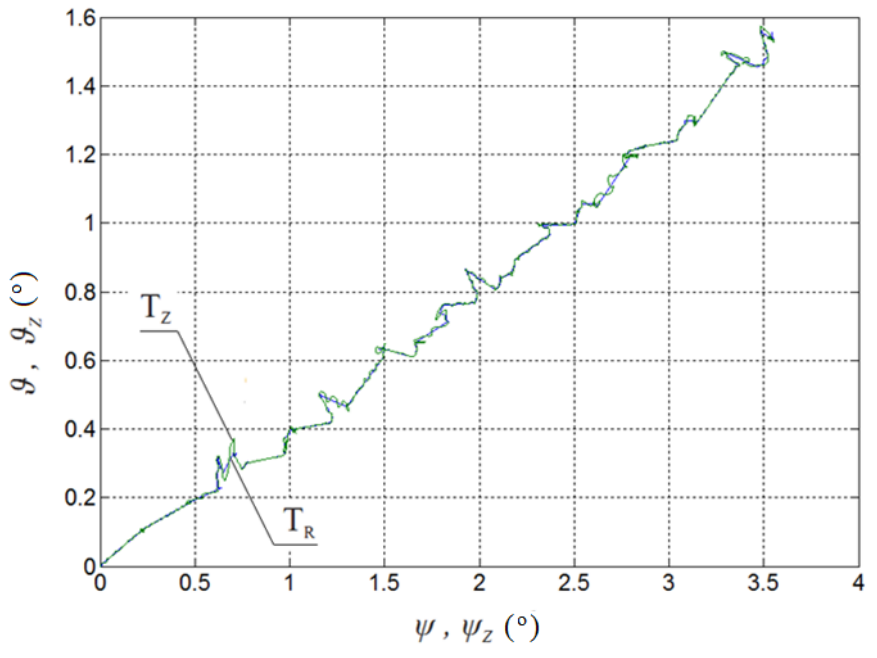
Figure 10. T Z set trajectory and pursued T R trajectory of the seeker axis without filtering the signals received from the infrared detector.